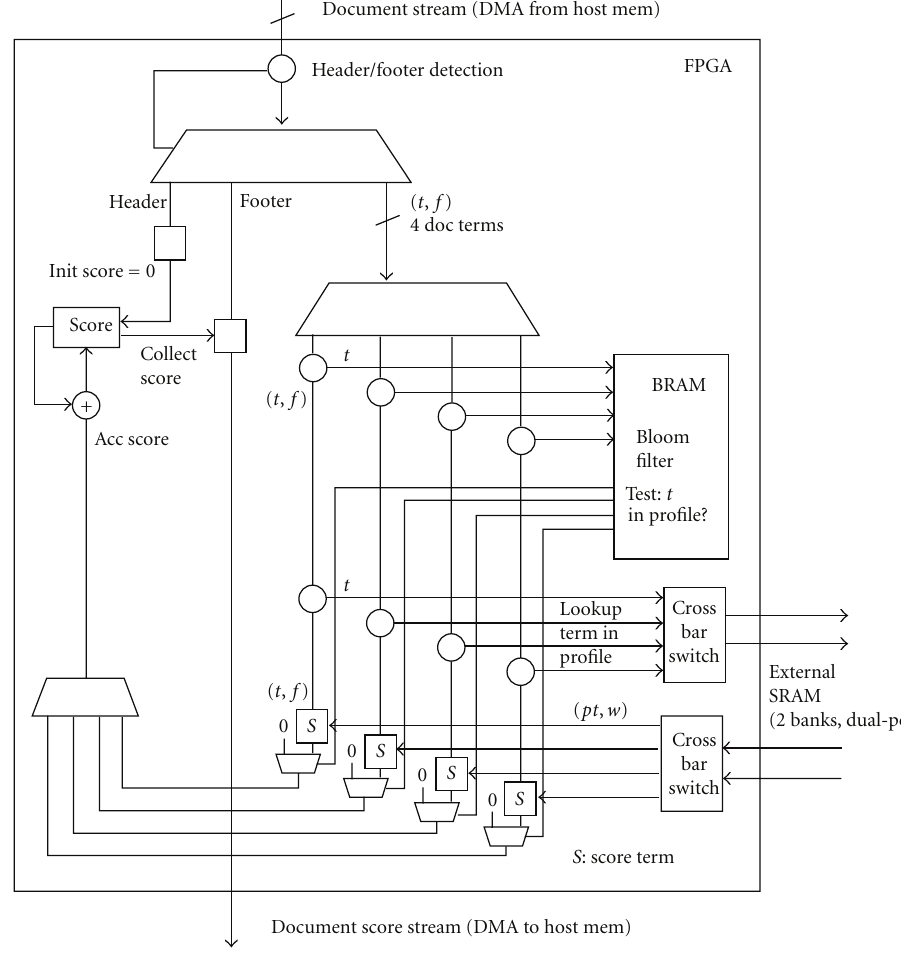
Figure 13: Implementing profile lookup and